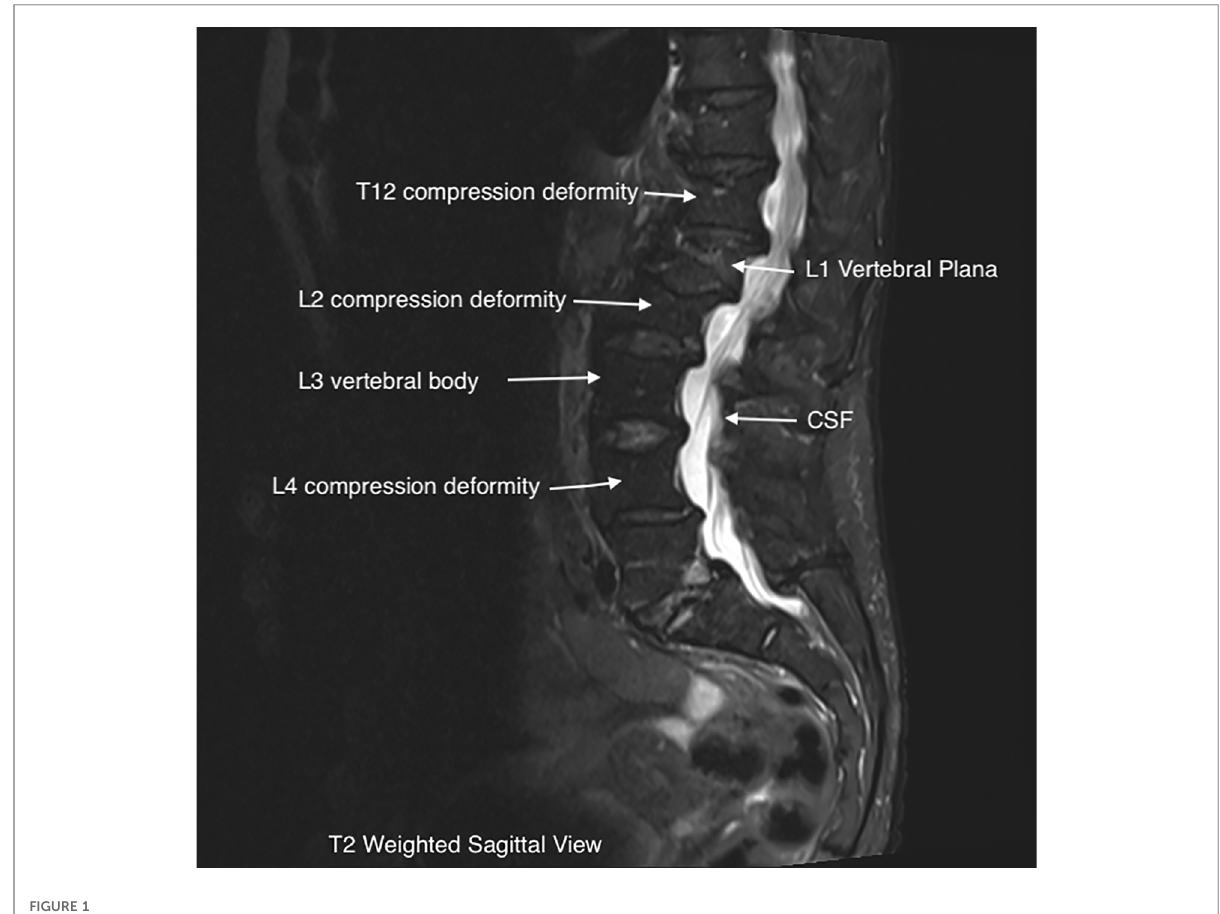
FIGURE 1 T2 weighted sagittal